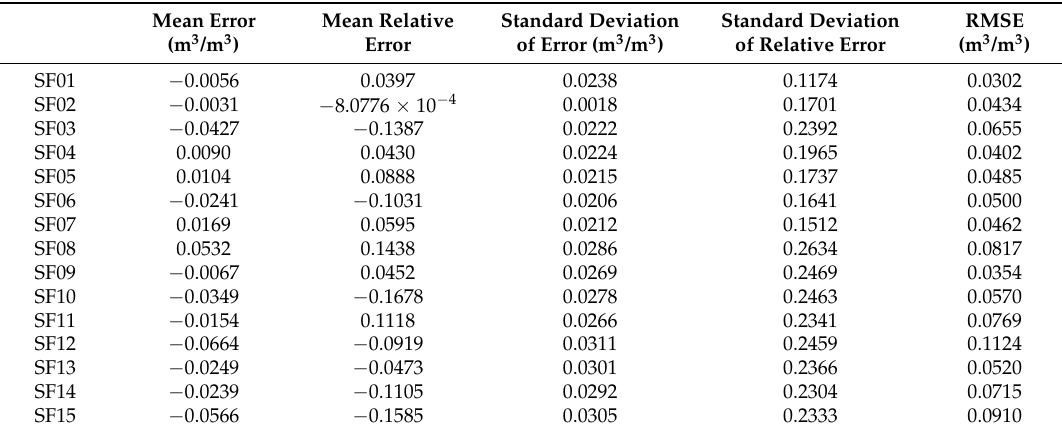
Table 5. Statistics obtained from the comparison of retrieved SSM against in situ SSM measurements.